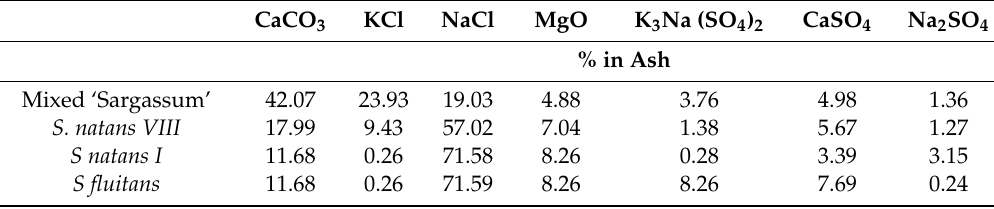
Table 3. Results of the X-ray di ff raction (XRD) analysis of Sargassum inundation (‘Mixed Sargassum’) and pelagic species of Sargassum from Turks and Caicos ( n = 1). CaCO 3 NaCl